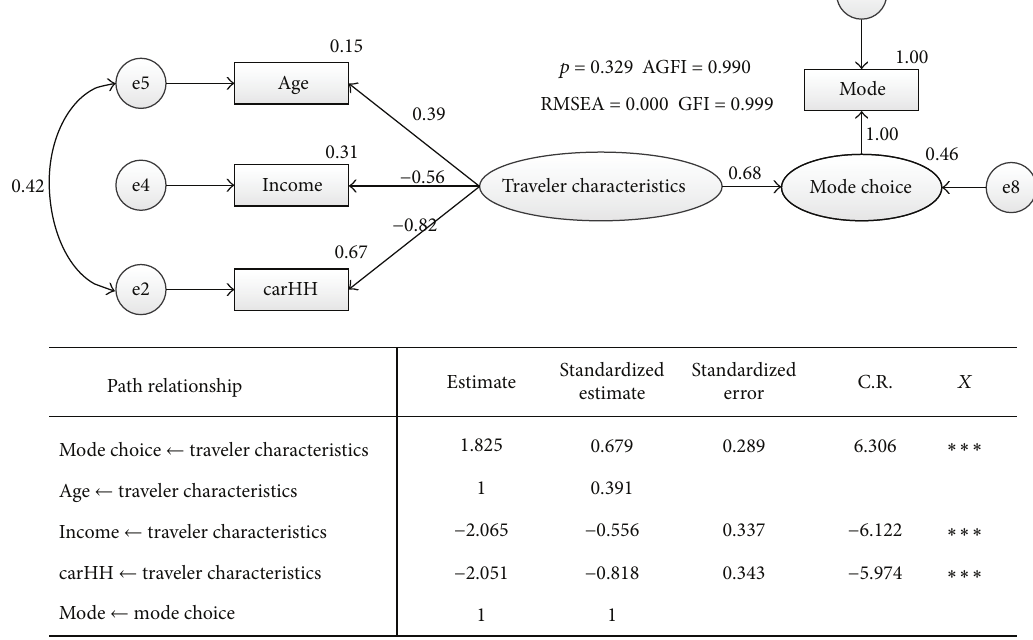
Proportion Area 1B. As shown in Table 1, Low Proportion Area 2 has a better green-mode travel environment than the other two areas, so it can be observed that a better green-mode travel environment tends to result in a higher proportion of green-mode travels even for the same traveler